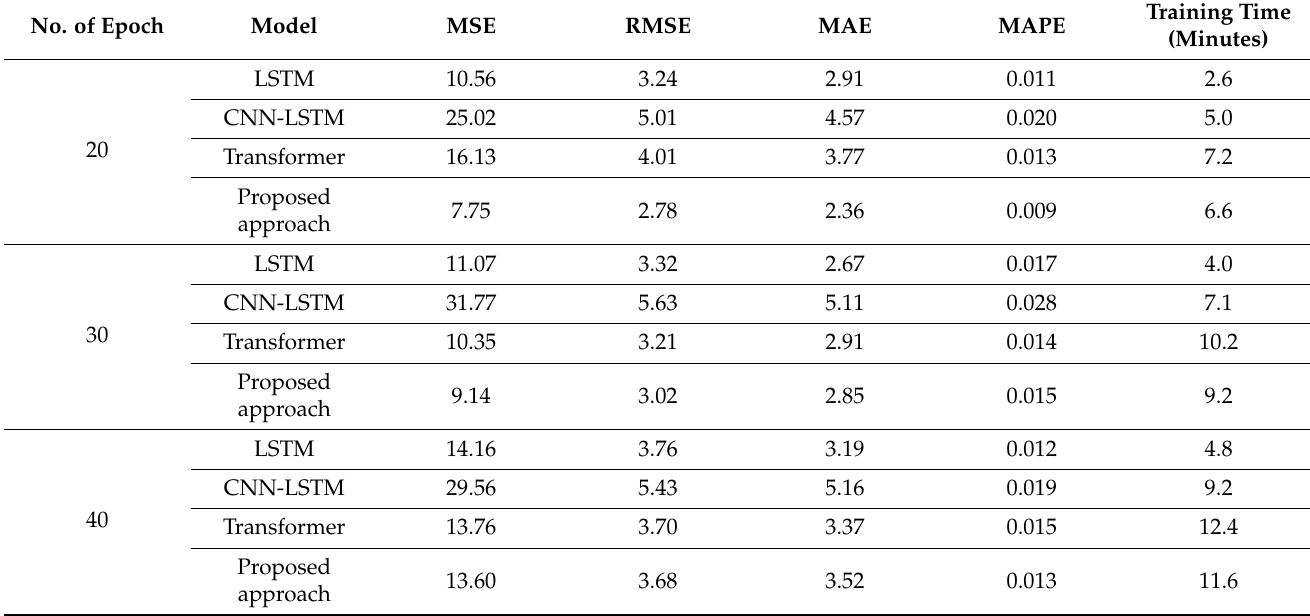
Table 3. The 30 min ahead forecasting performance of LSTM, CNN-LSTM, Transformer models, and our proposed approach (Single- Dense Layer